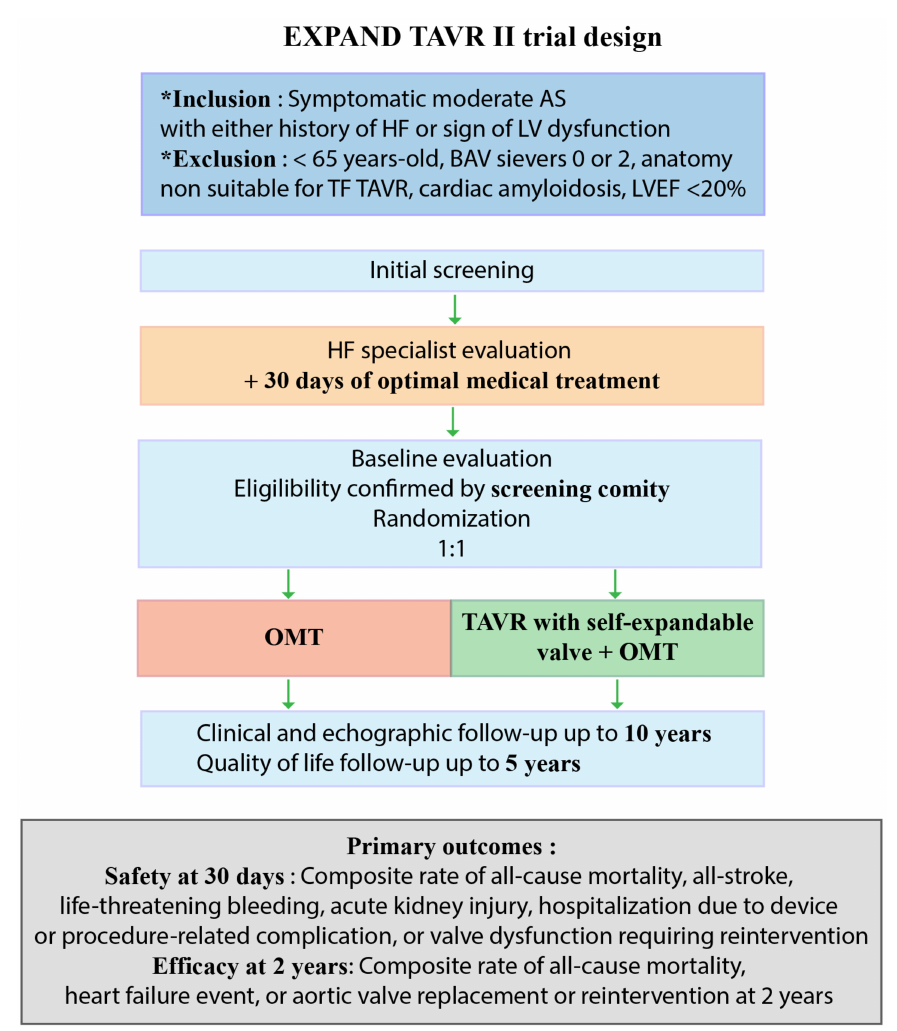
Figure 3. EXPAND TAVR II trial study design; AS, aortic stenosis; BAV, bicuspid aortic valve; HF, heart failure; OMT, optimal medical therapy; TAVR, transcatheter aortic valve replacement; TF,